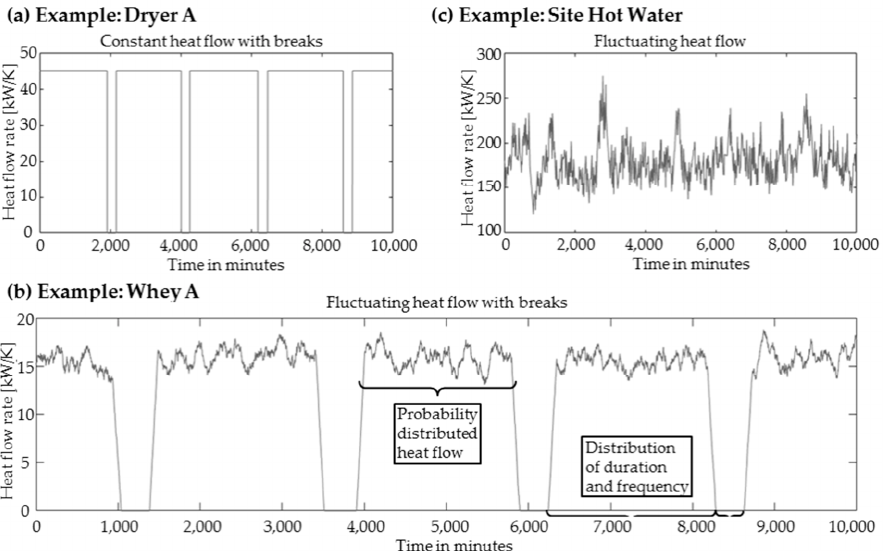
Figure 4. Characteristic time series for a ( a ) constant and ( b ) fluctuating heat flow with time intervals in off-production and ( c ) a continuously fluctuating heat flow.